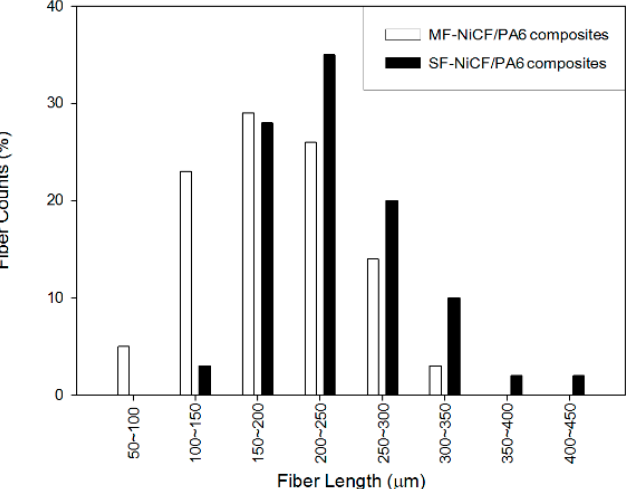
Figure 3. A histogram showing the fiber length distribution of the MF-NiCF/PA6 and SF-NiCF/PA6 composites.